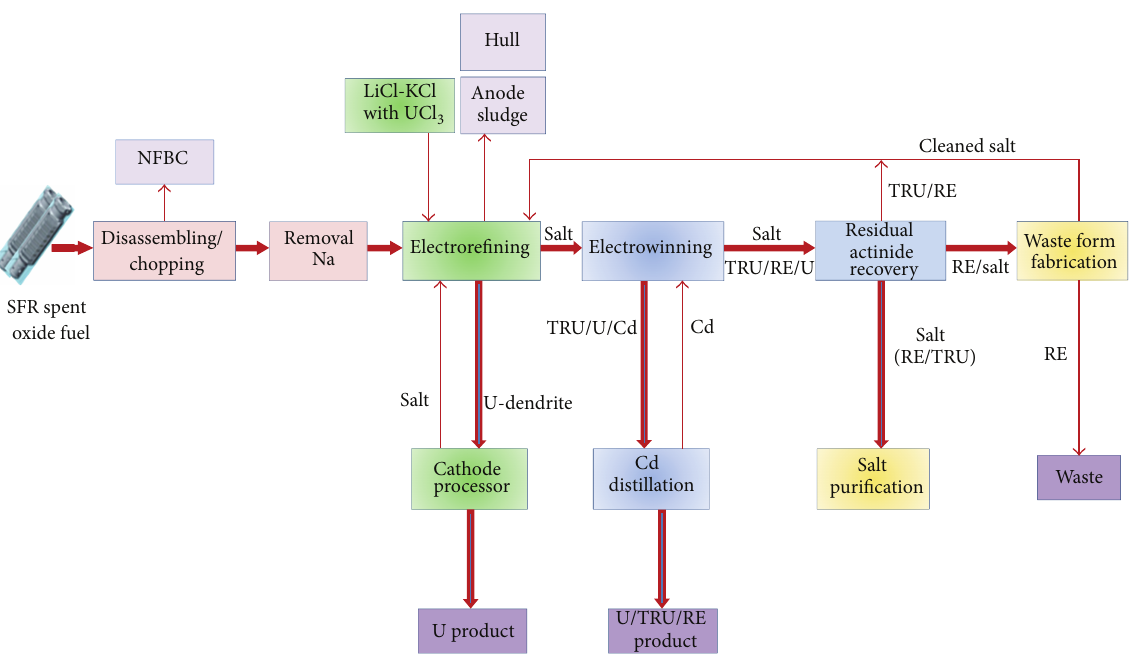
Figure 4: The process flow diagram of pyroprocess.